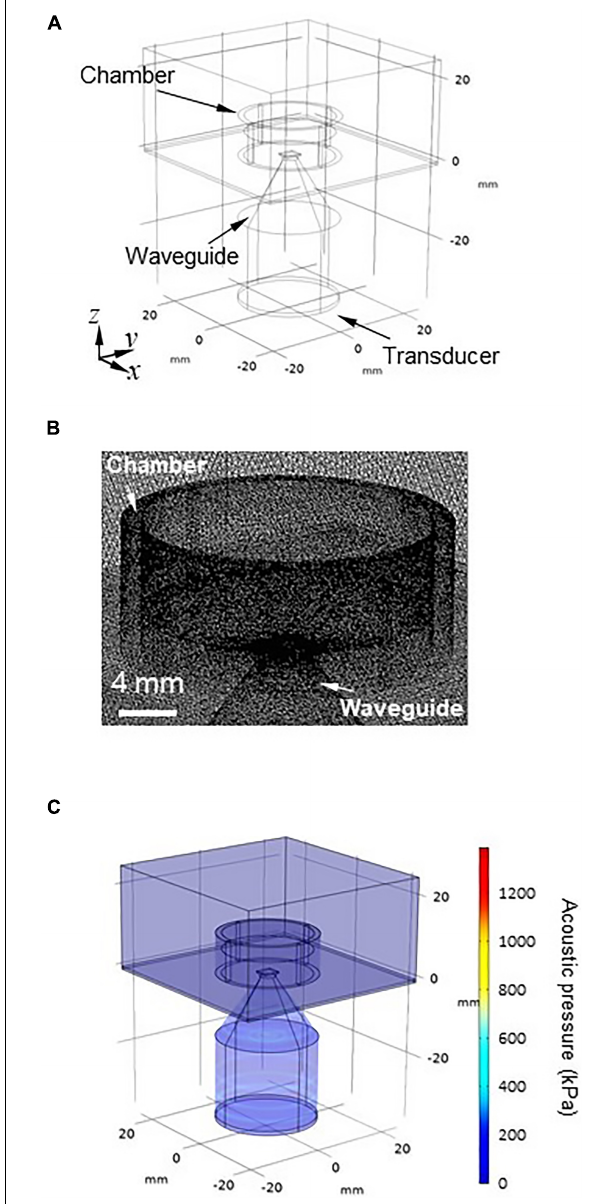
FIGURE 3 | 3D modeling for numerically obtaining the spatial pressure distribution. (A) Geometry of the 3D model. The 3D model has six parts: (i) transducer, (ii) waveguide, (iii) MEA probe with a glass camber, (iv) brain slice, (v) artificial cerebrospinal fluid (ACSF) solution, and (vi) air surrounding the five components. (B) Mesh image showing the space around the chamber of the MEA probe using model geometry. The geometry of the 3D model was discretized to the extra fine mesh (maximum = 1.23 mm, minimum = 0.123 mm). (C) Typical overview of the acoustic pressure distribution of the 3D model, which was numerically obtained for the size parameters d = 4.0 mm and l = 20